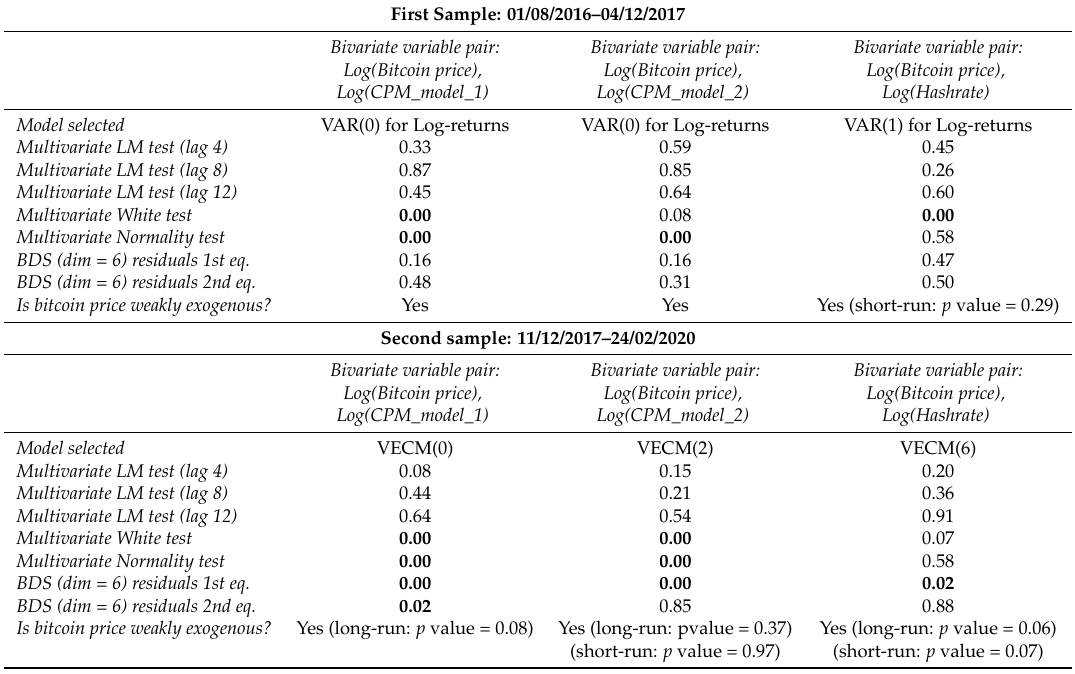
Table 5. Misspecification tests on the residuals from the bivariate models. p -values smaller than 5% are reported in bold